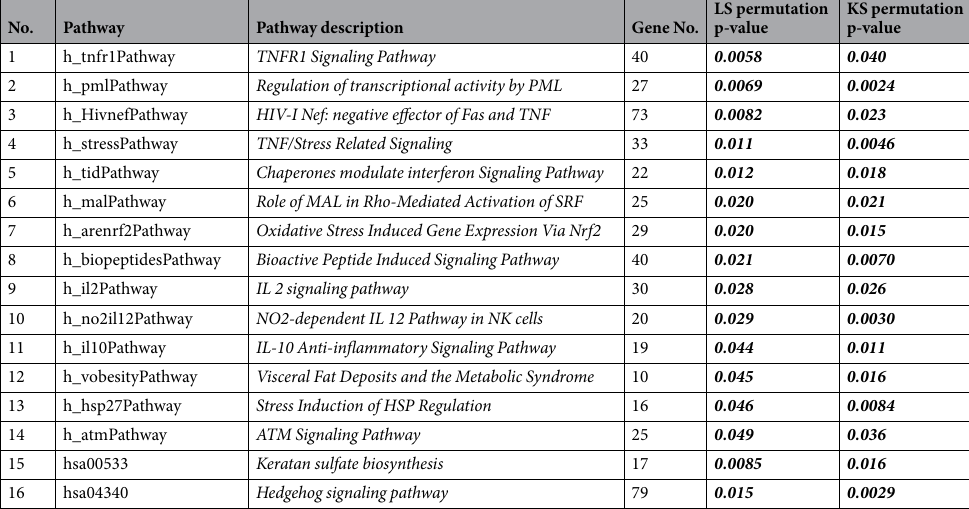
Table 5. Results of pathway analysis. LS permutation: Least square permutation; KS permutation: Kolmogorov– Smirnov permutation. The LS/KS permutation tests, which find gene sets that have more differentially expressed genes among the classes than expected by